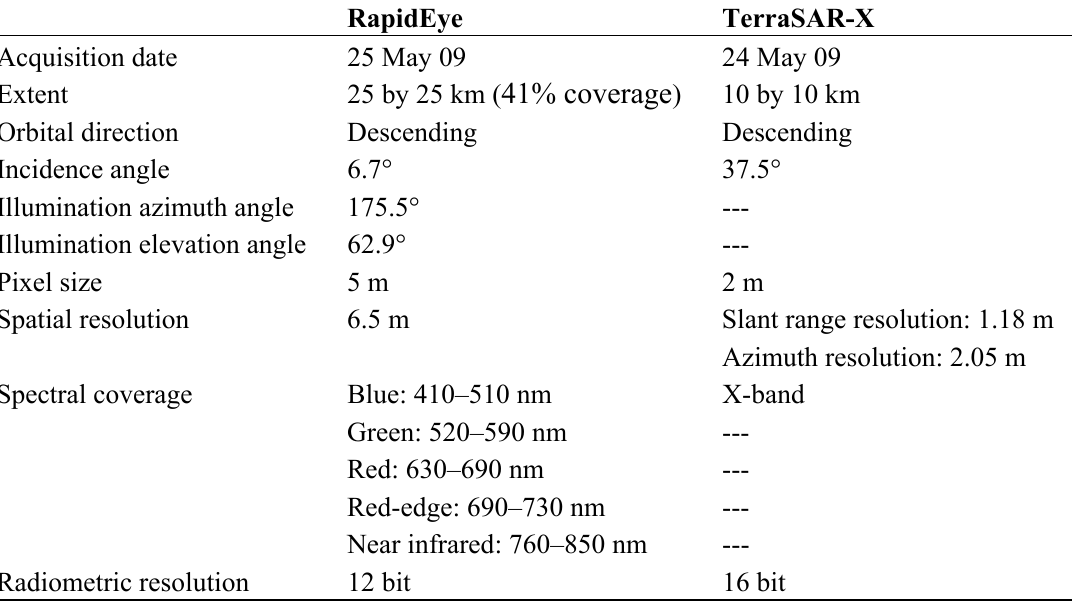
Table 1. Characteristics of the satellite